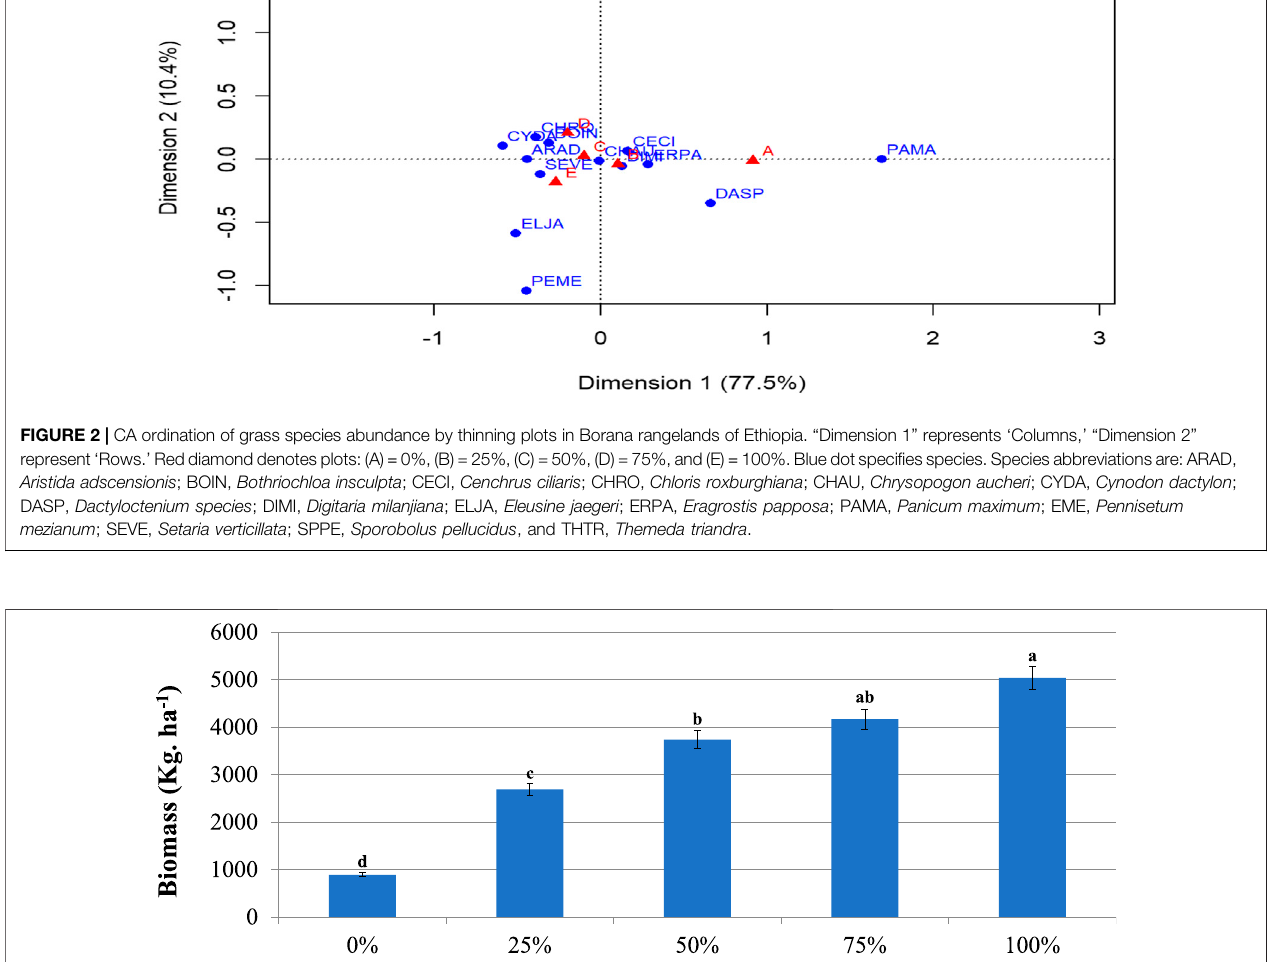
Table A2 . Percentage composition of grass species differed